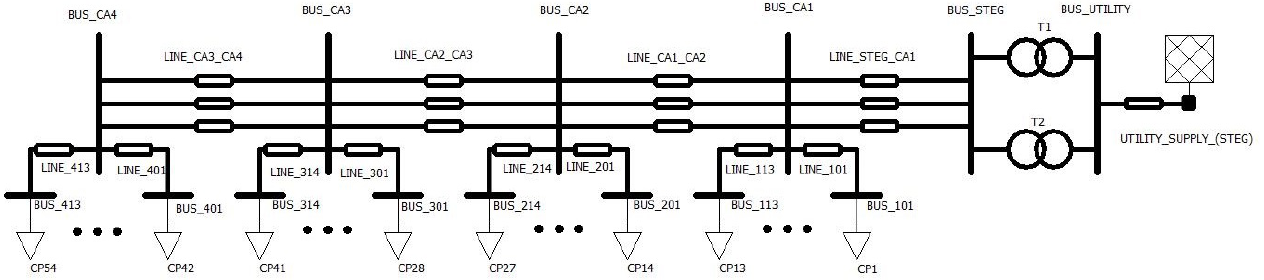
Figure 3. Electrical diagram of the ENSTAB charging infrastructure.